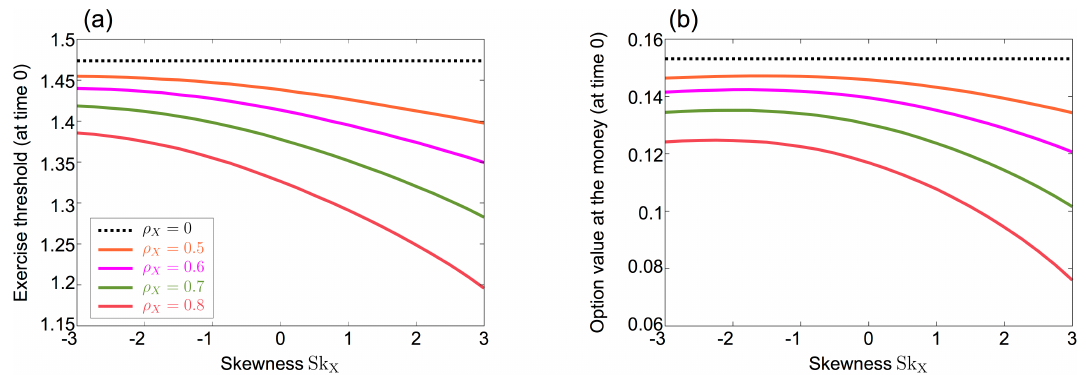
Figure 8. Plots of exercise threshold ( a ) and option value ( b ) at time t = 0, vs. skewness Sk X , for different values of ρ X (0, 0.5, 0.6, 0.7, 0.8). Other parameters are given in the text. In particular, λ =